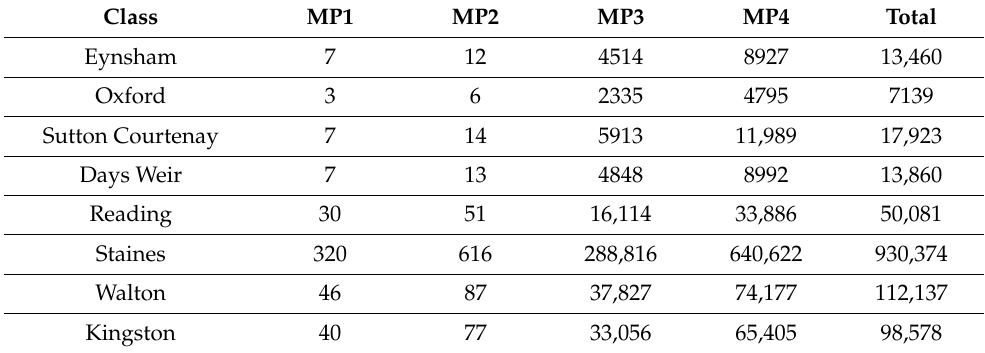
Table 2. Average annual suspended Microplastic mass load (kg/year) by microplastics particle size and by river reach (scenario